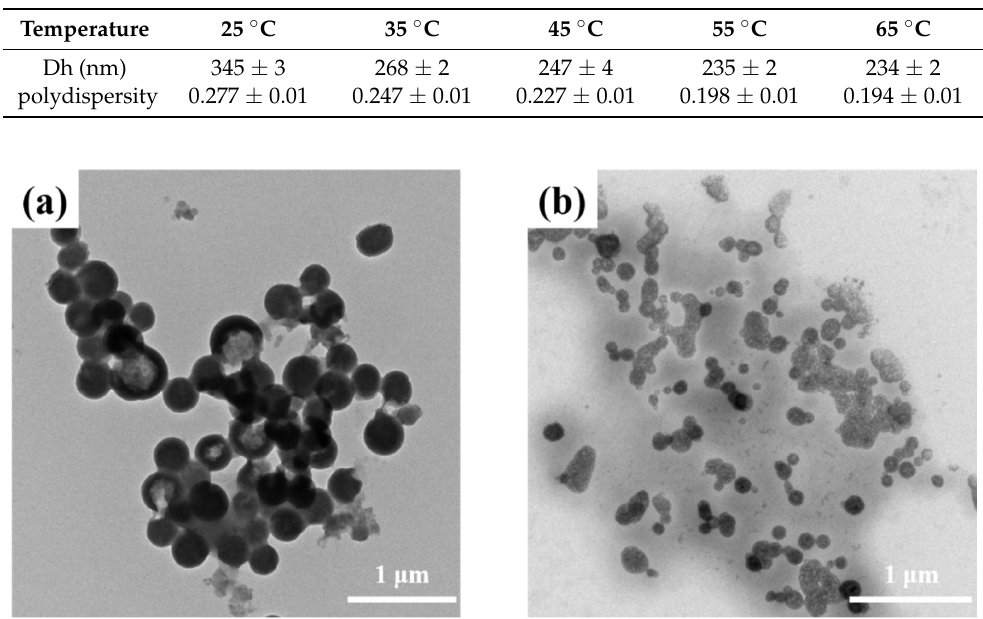
Figure 6. DLS measurement of PNI-C 60 micelles under different temperatures. Table 1. DLS measure results of PNI-C 60 under different temperatures. Table 1. DLS measure results of PNI-C 60 under different temperatures.